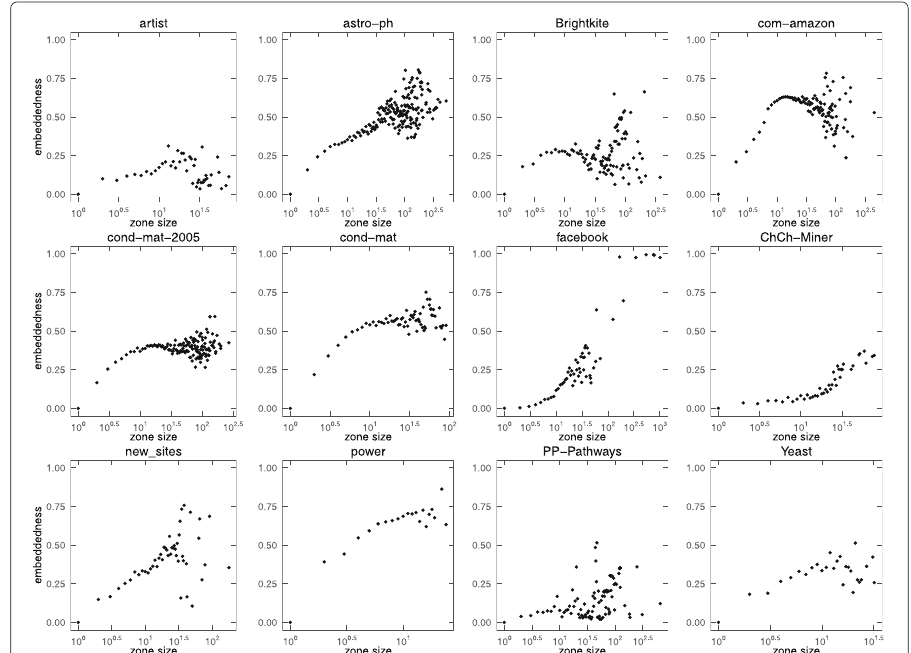
Fig. 23 Embeddedness in real-world networks